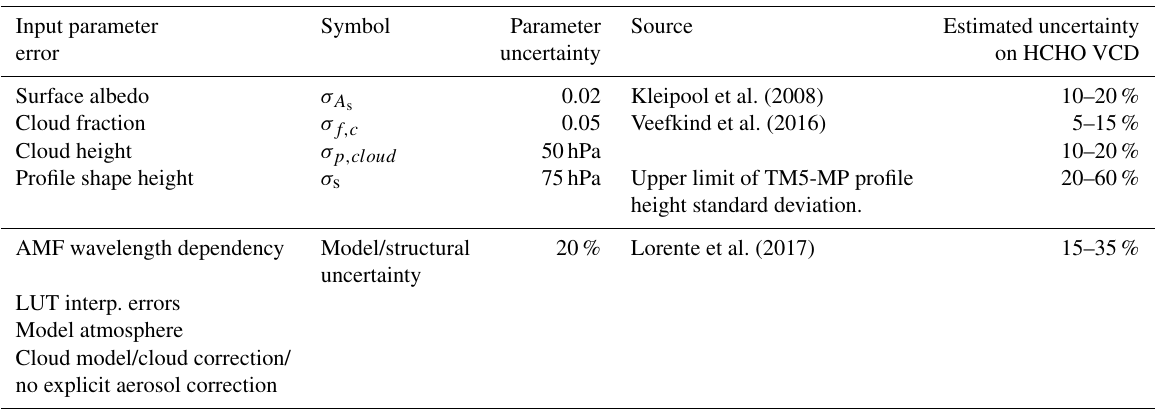
Table 8. Summary of the different error sources considered in the air mass factor uncertainty